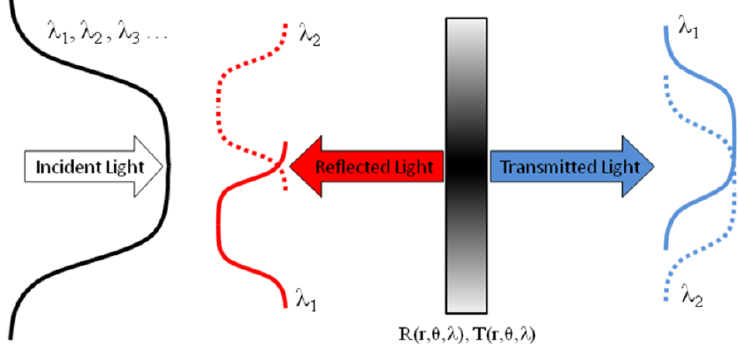
Figure 1. Conceptual performance of a space variant